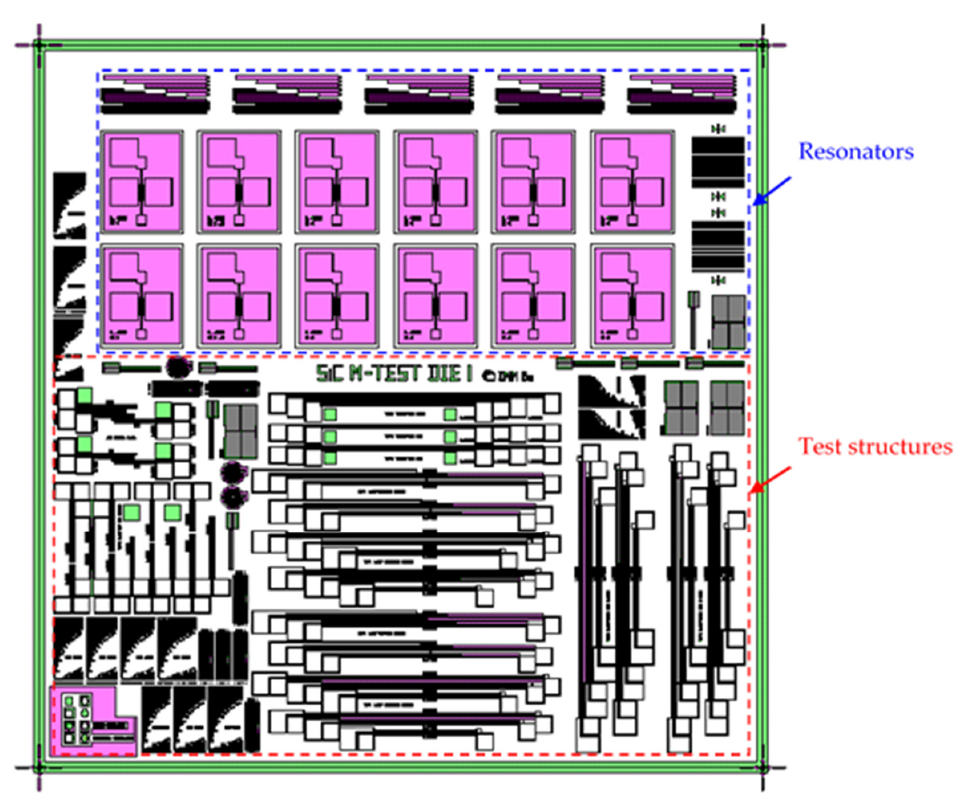
Figure 2. Micromachined test structures mask layout.